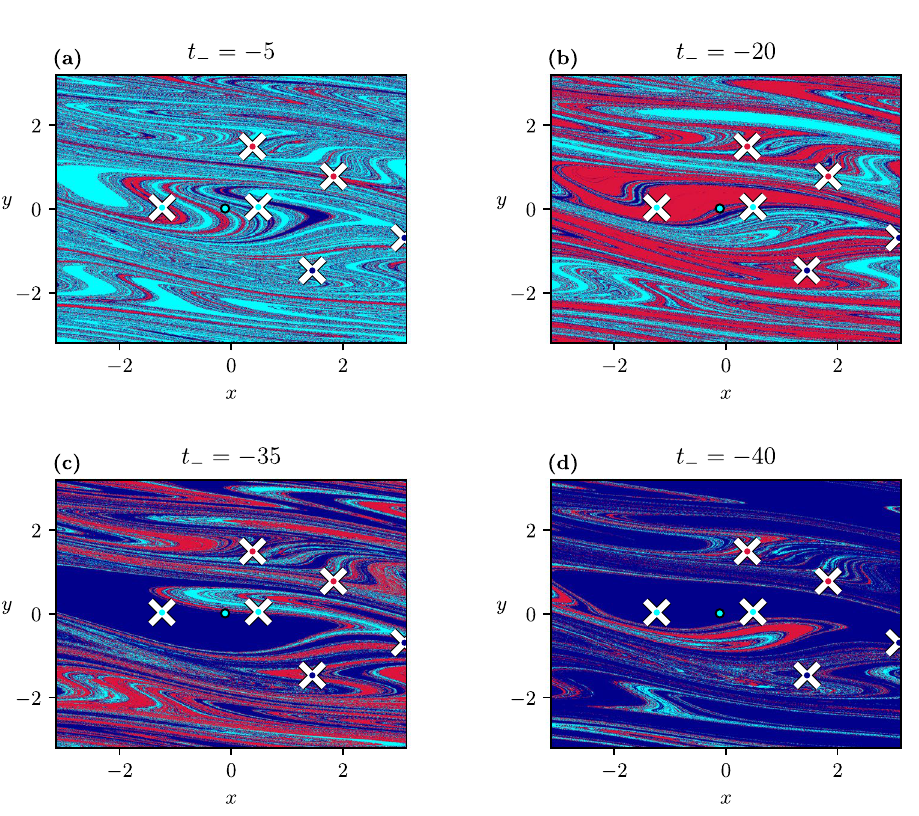
Figure 6. The dependence of the scenario-dependent basins of attraction on t − with scenarios starting at C − = 0.1 ending at C + = 0.5835, t + = 100 ( I 2 ), with t r = 5. For each scenario, t − is indicated above the panels and the tipping probabilities can be read off from Fig. 5b. The basin belonging to t − = 0 is given in S. Fig.